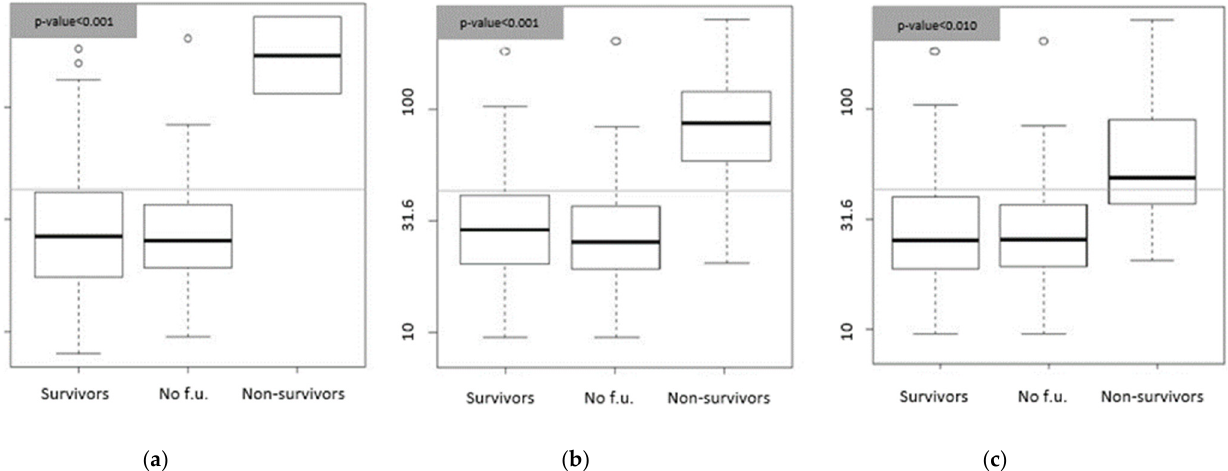
Figure 2. Bio-ADM concentrations expressed in pg/mL. ( a ) Box plot. Survivors: distribution of the Bio-ADM values of the patients who survived at 24 h ( n = 107, median = 26.7); no f.u.: distribution of Bio-ADM values in patients for whom follow-up is not available ( n = 44, median = 25.5); non- survivors: distribution of the Bio-ADM values of the patients who were dead within 24 h ( n = 2, median = 183.8). ( b ) Box plot. Survivors: distribution of the Bio-ADM values of the patients who survived after 10 days ( n = 101, median 28.9); no f.u.: distribution of Bio-ADM values in patients for whom follow-up is not available ( n = 44, media = 25.5); non-survivors: distribution of the penKid values of the patients who were dead after 10 days ( n = 8, median 88.5). ( c ) Box plot. Survivors: distribution of the Bio-ADM values of the patients who survived after 30 days ( n = 94, median 25.3); no f.u.: distribution of Bio-ADM values in patients for whom follow-up is not available ( n = 44 median 25.3); non-survivors: distribution of the penKid values of the patients who were dead after 30 days ( n = 15, median = 48.7). Gray lines represent the 99th percentile of normal values (43 pg/mL). No relationship was found between Bio-ADM values and the development of complications both major and minor. In the first group of patients, the mean ± SD was 43.03 ± 45.63 pg/mL, and in the patients that developed complications, this value was 49.4 ± 32.89 pg/m ( p -value